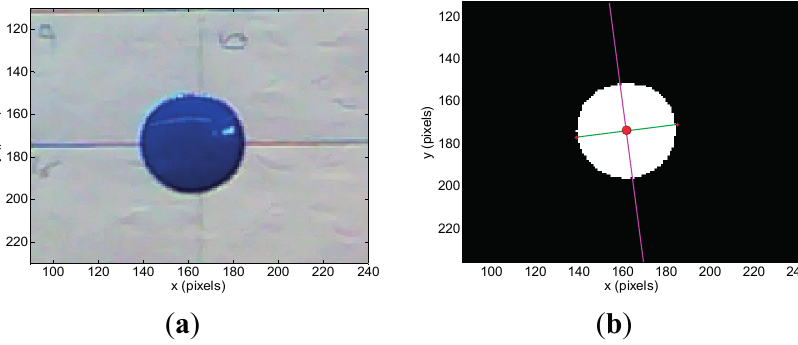
Figure 3. Pushpin: ( a ) original image and ( b ) segmented image showing the centroid (red dot), inclination (magenta line) and diameter in pixels (green line).